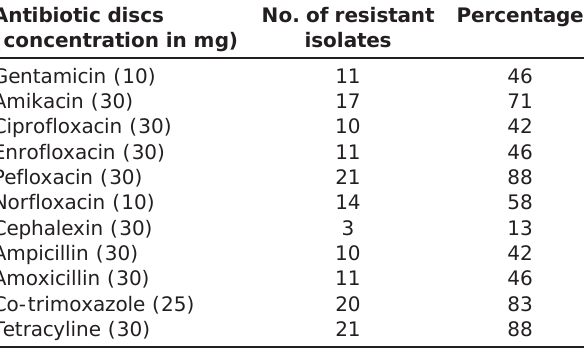
Table-2: Antibiotic resistance pattern of avian E. coli isolates. Antibiotic discs (concentration in mg)